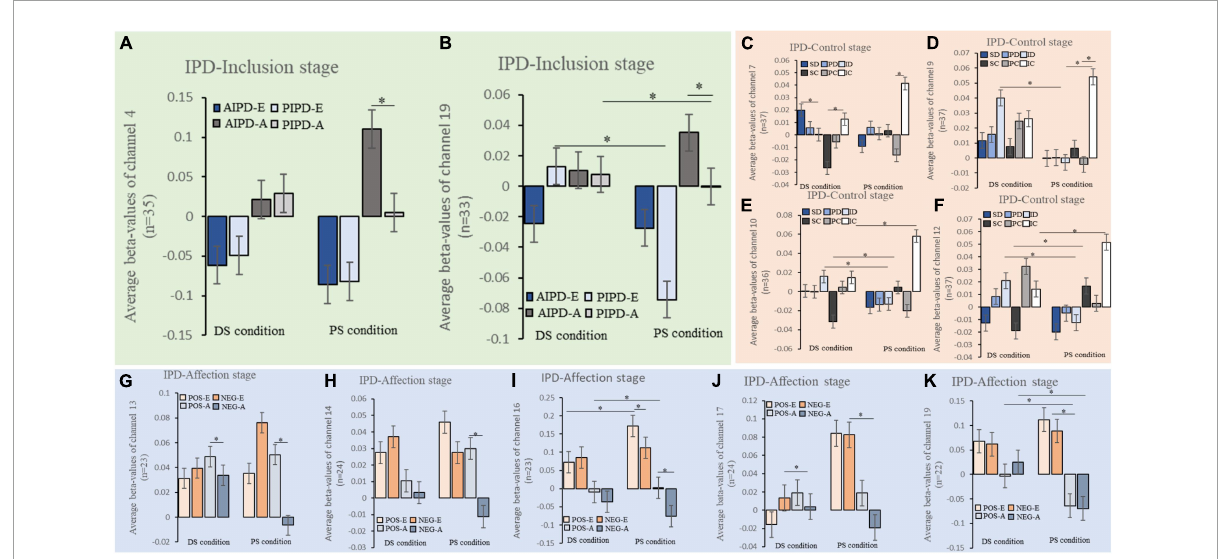
FIGURE6 Beta value difference of Oxy-Hb changes in conditions and tasks of each IPD stage. (A,B) Differences of the Oxy-Hb changes in conditions and tasks of channels 4 and 19 in the IPD-inclusion stage. (C–F) Simple effects analysis results in channels 7, 9, 10, and 12 in the IPD-control stage. (G–K) (cid:49) beta-values of Oxy-Hb differences in conditions and tasks of channels 13, 14, 16, 17, and 19 in the IPD-affection stage. DS, differing social status; PS, peer social status; AIPD-E, active interpersonal distance in evaluation periods; PIPD-E, passive interpersonal distance in evaluation periods; AIPD-A, active interpersonal distance in action periods; PIPD-A, passive interpersonal distance in action periods. SD stands for social IPD (1.2 m) under deprivation processes; PD means personal IPD (0.6 m) under deprivation processes; ID means intimate IPD (0.3 m) under deprivation processes. SC stands for social IPD (1.2 m) under controllable processes; PC stands for personal IPD (0.6 m) under controllable processes; IC stands for intimate IPD (0.3 m) under controllable processes. POS-E means positive IPD feedback in evaluation periods. NEG-E means negative IPD feedback in evaluation periods. POS-A means positive IPD feedback in actions. NEG-A means negative IPD feedback in action periods. The column shows the mean beta-values/ (cid:49) beta-values in each channel, and the error bar shows the standard error. ∗ p ≤